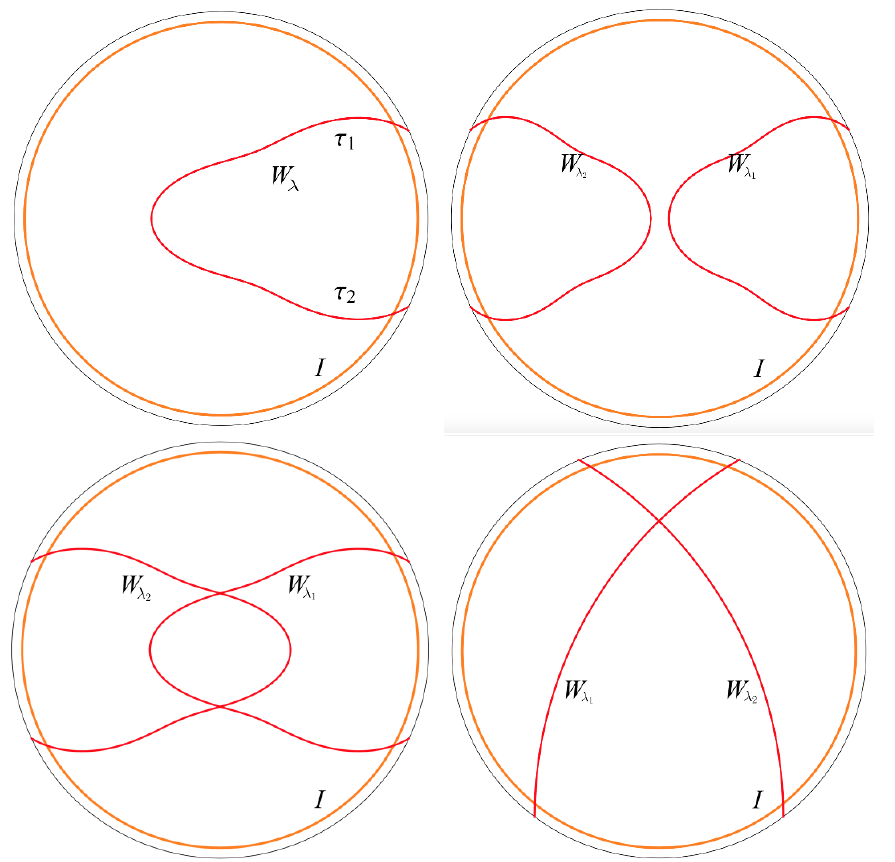
Figure 4 . Several Euclidean Wilson line con(cid:12)gurations, equivalent to di(cid:11)erent (cid:12)nite tem- perature correlation functions of the bi-local operator O (cid:21) ( x 1 ; x 2 ): the top-left (cid:12)gure shows hO (cid:21) ( (cid:28) 1 ; (cid:28) 2 ) i (cid:12) = hW (cid:21) ( C (cid:28) ) i , the top-right (cid:12)gure yields the equality of the time-ordered corre- 1 ;(cid:28) 2 lators hO (cid:21) ( (cid:28) 1 ; (cid:28) 2 ) O (cid:21) ( (cid:28) 3 ; (cid:28) 4 ) i (cid:12) = hW (cid:21) ( C (cid:28) ) W (cid:21) ( C (cid:28) ) i , the bottom-left (cid:12)gure shows a pair of 1 2 1 1 ;(cid:28) 2 2 3 ;(cid:28) 4 intersecting Wilson lines that can be disentangled to the top-right con(cid:12)guration, while the bottom- right (cid:12)gure gives the out-of-time-ordered con(cid:12)gurations. Note that the results are independent of the trajectory of the Wilson line inside of the bulk and only depend on the location where the Wilson lines intersect the